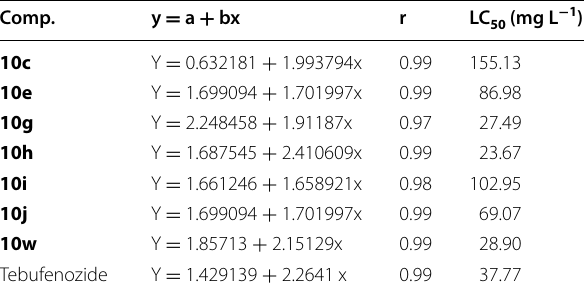
values for insecticidal activity against Plutella 50